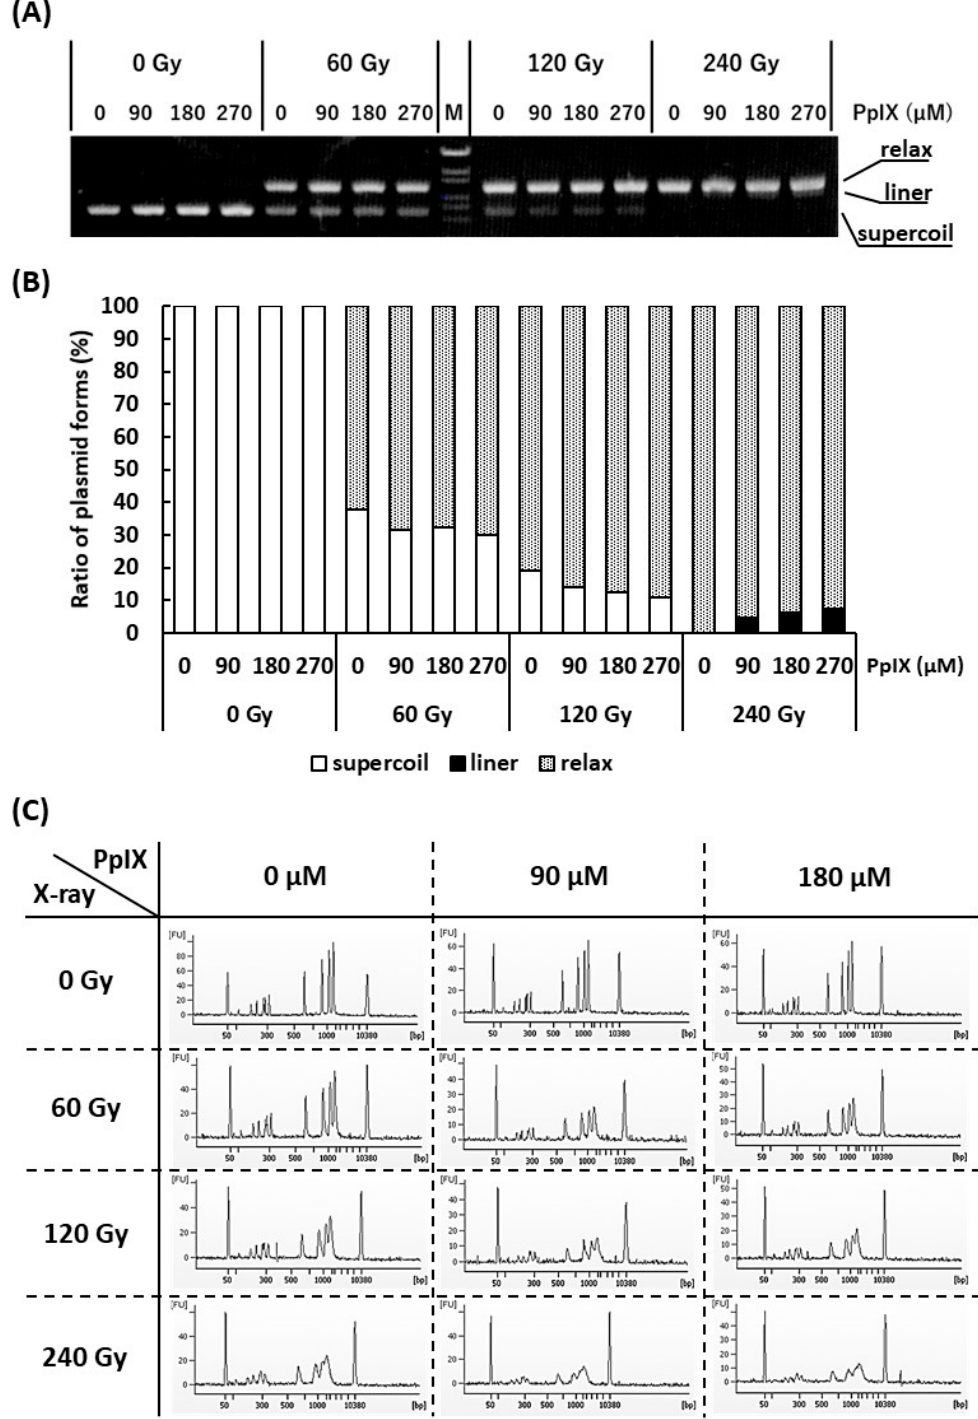
Figure 3. Evaluation of strand breaks (SBs) by X-ray irradiation and enhancement of SBs by PpIX for plasmid pBR322. ( A ) Agarose gel electrophoresis (0.7% agarose) of plasmids irradiated with X-ray at di ff erent concentrations of PpIX. “M” is the DNA ladder [OneSTEP Marker 6 ( λ / Sty I digest), Nippon Gene, Japan]. ( B ) The fluorescence intensity of ( A ) was quantified, and the ratio of supercoiled to relaxed plasmid was calculated. ( C ) Capillary gel electrophoresis of DNA ladder mixed with PpIX and irradiated with X-ray. The 50 bp and 10,380 bp peaks belong to an internal standard marker.